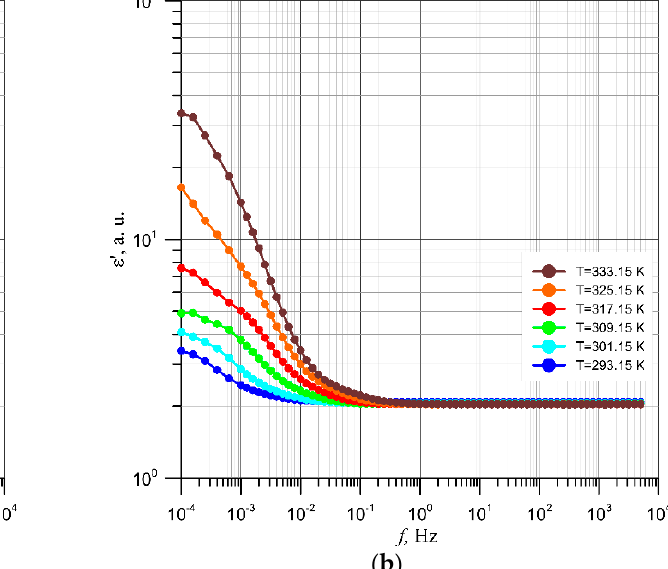
Figure 3. Frequency dependencies of the phase shift angle of mineral insulating oil with a moisture content of 5 ppm—( a ) and moistened mineral oil—( b ) at temperatures from 293.15 K to 333.15 K in steps of 8 K.